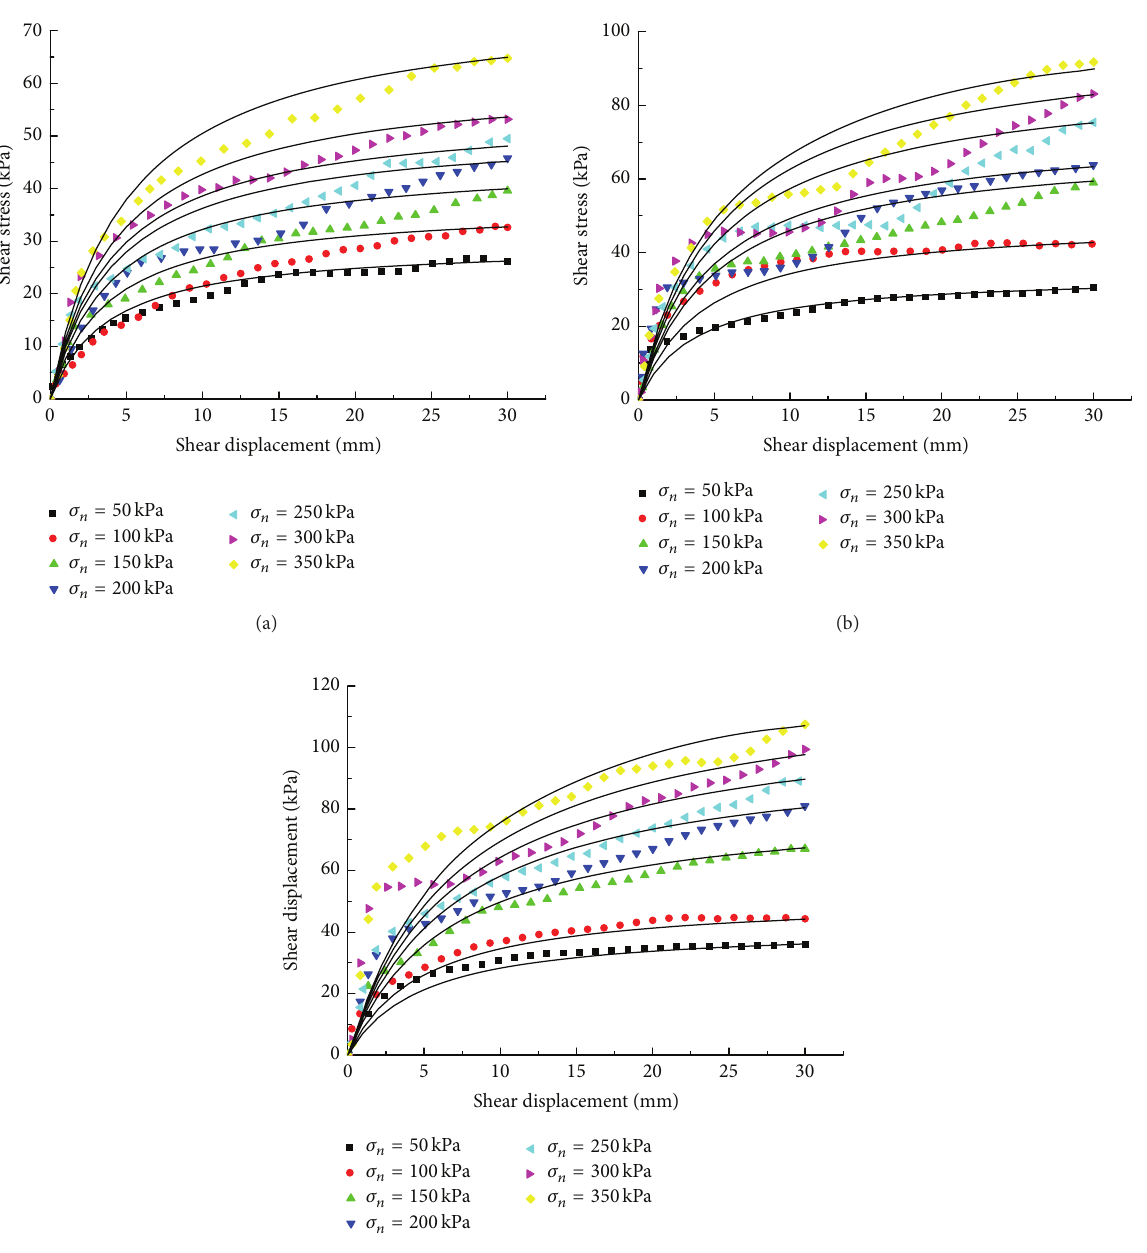
Figure 14: Shear-stress-displacement curves of the interface between clay and concrete ( 𝜎 𝑛𝑖 = 400 kPa).